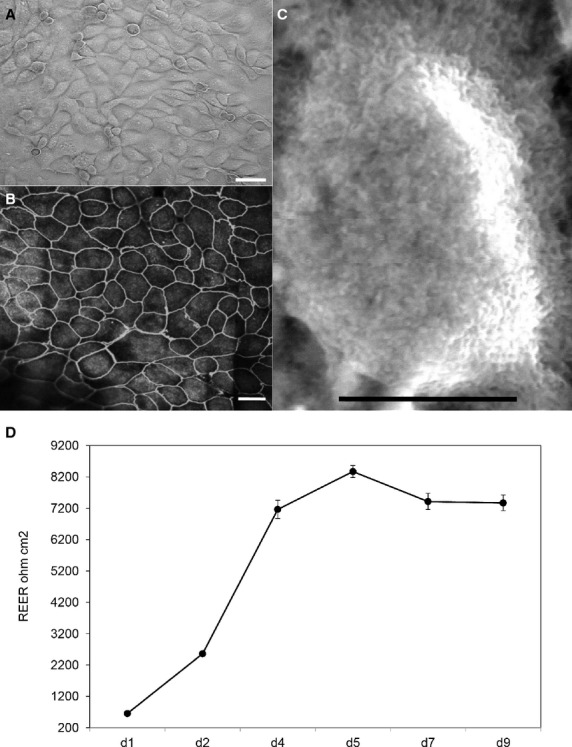
Characterization of IPEC-J2 cell monolayer. (A) Light microscope image of confluent cell monolayer grown on a tissue culture flask, scale bar equals 20 μm. (B) Confocal micrograph showing a top view of IPEC-J2 monolayer grown on transwell filter for 9 days, the cell borders can be distinguished by immunofluorescent staining of tight junction protein ZO-1, scale bar equals 20 μm. (C) Top view of well-differentiated IPEC-J2 cell with microvilli observed by scanning electron microscopy, figure contains one cell from cell monolayer grown on transwell filter for 9 days, scale bar equals 5 μm. (D) Progression in transepithelial electrical resistance (TEER) values of cells grown on transwell filter for 9 days. Data are given as means (±SEM) of 20 separate experiments. They were assigned to experimental treatment on day 9, respectively.